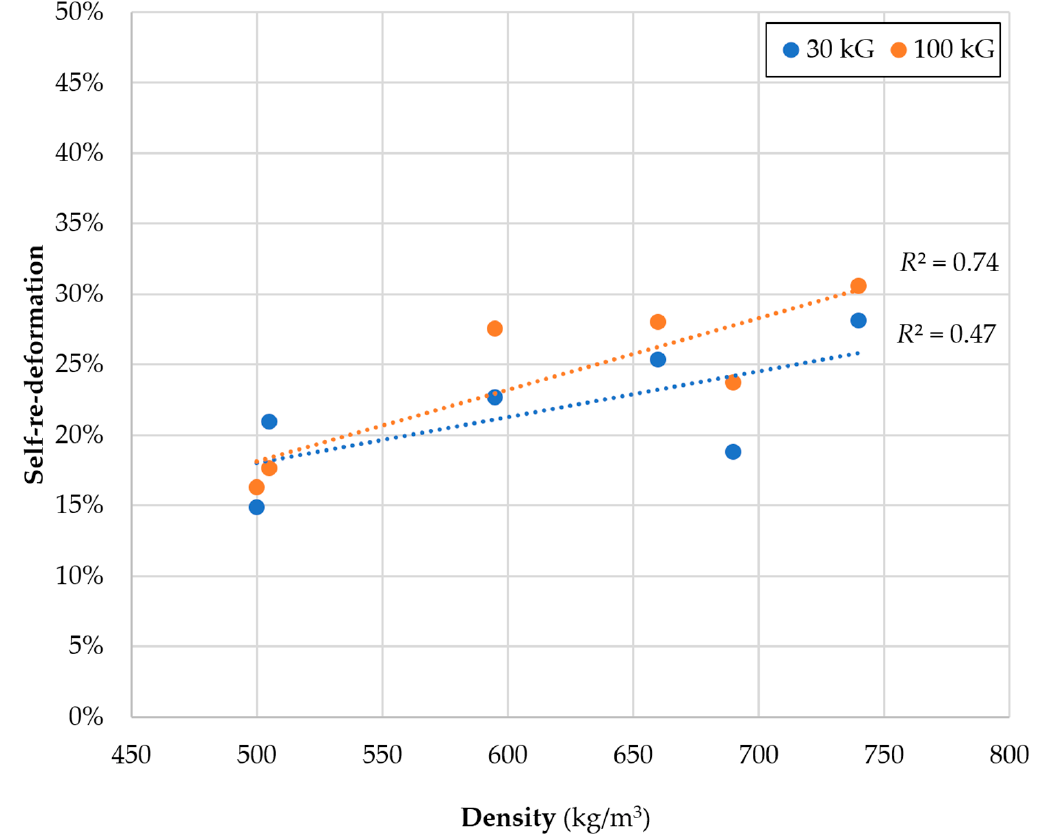
Figure 13. The ability of self-re-deformation in the R cross-section versus wood density.